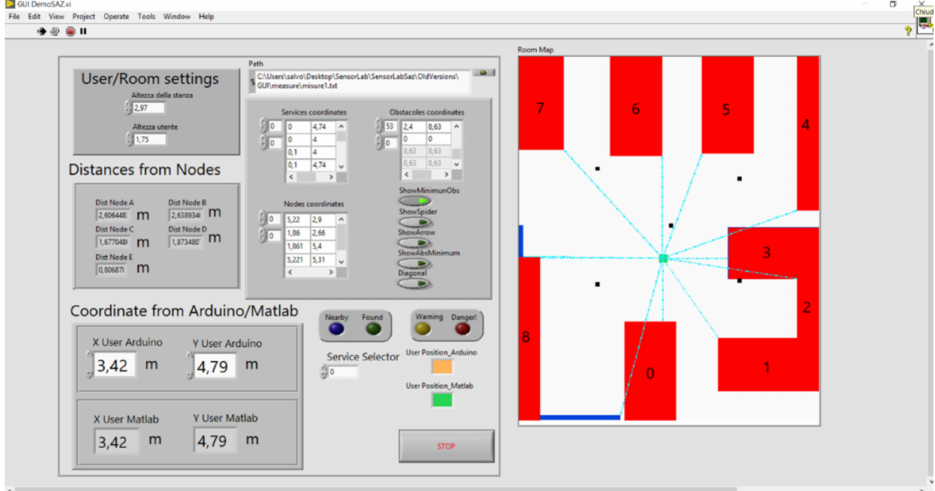
Figure 4. The minimum user-objects distance estimation functionality implemented in the Manage- ment